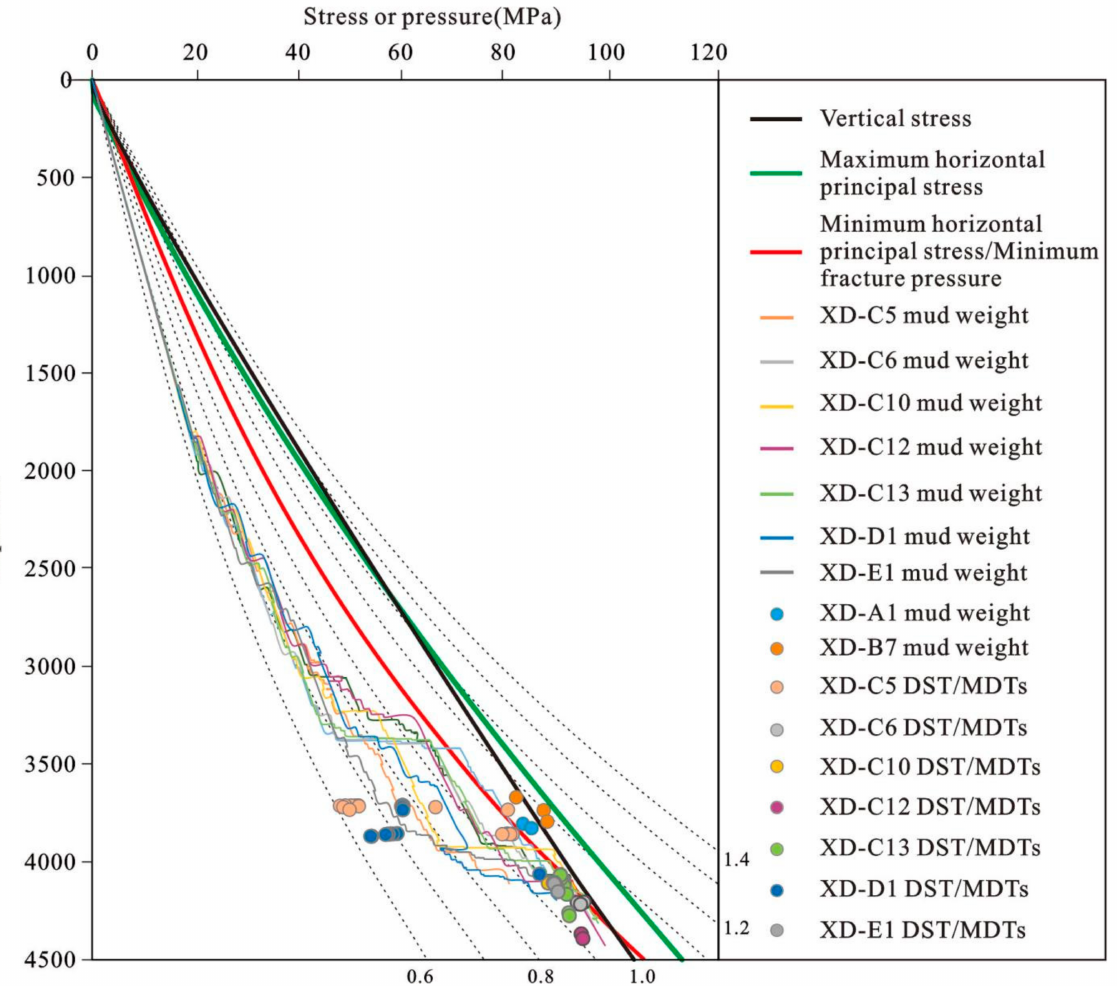
Figure 10. Hydraulic fracture risk of Huangliu Formation in the present stress and pressure